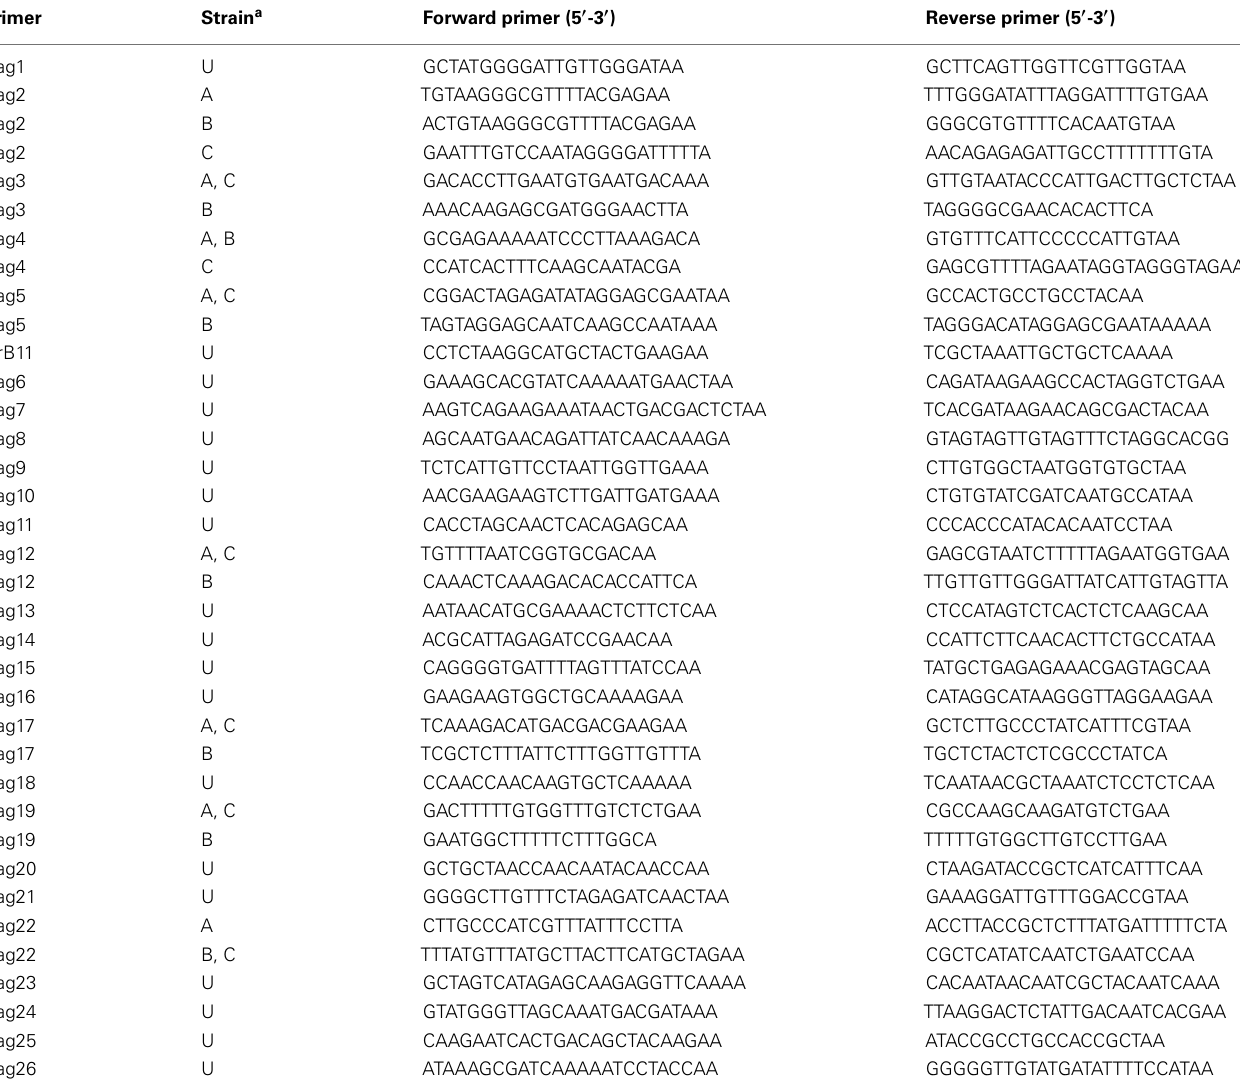
TableA1 | Open reading frame primer pairs selected for real time RT-PCR.